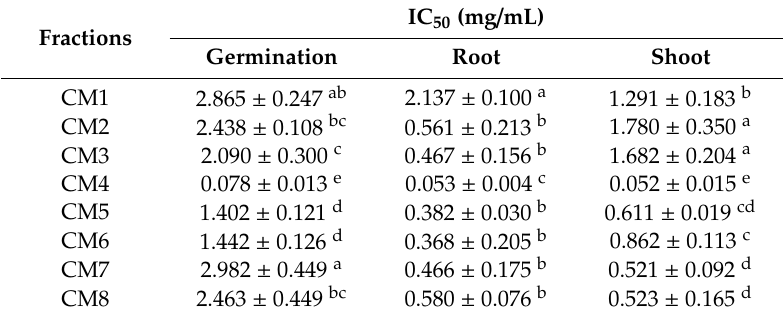
Table 2. E ff ects of di ff erent fractions of C. militaris on germination and growth of radish.